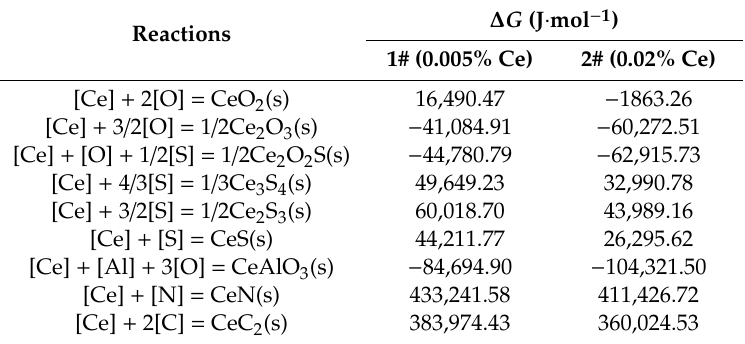
Table 4. The ∆ G of REM inclusions in LDX2101 duplex stainless steels containing 0.005% and 0.02% Ce at